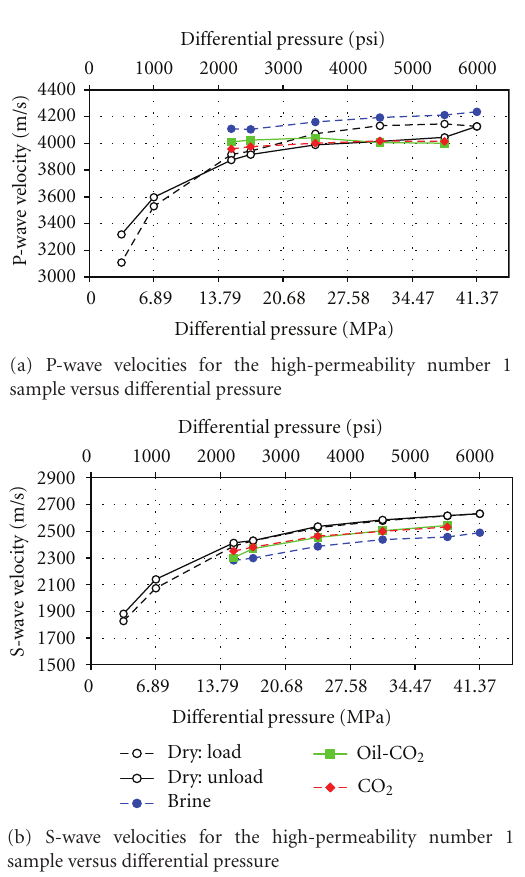
Figure 7: P- and S-wave velocities for the high-permeability number 1 sample versus di ff erential pressure for dry rock, brine saturated, and when flushed with the oil-CO 2 mixture, and CO 2